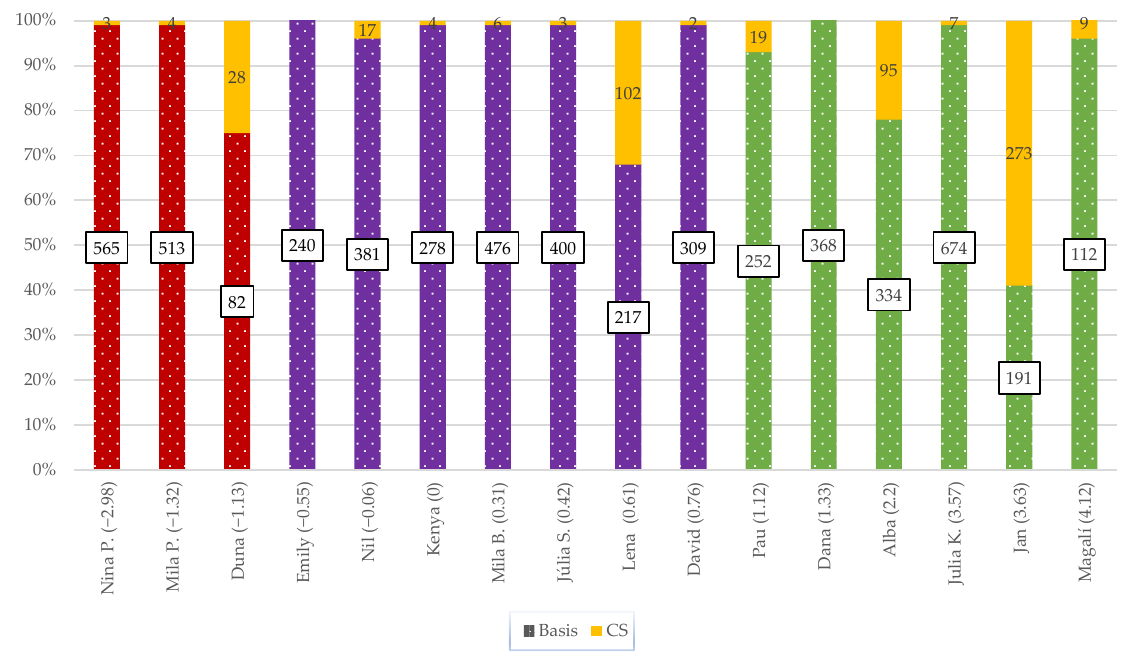
Figure 8. Basis and CS according to children’s language dominance (child (MLUD)).